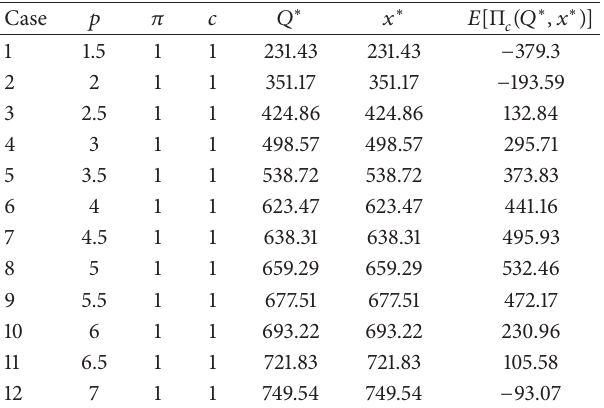
Figure 2: Optimal profits in the centralized system with different determined prices. Table 1: Centralized solution under different determined prices.